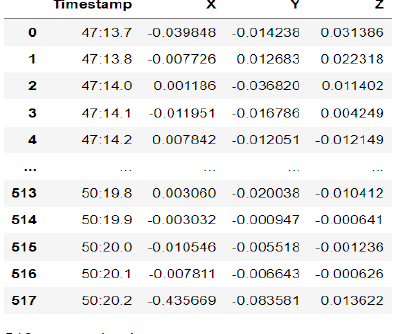
Figure 57. Merged gyroscope (angular velocity) sensor data.